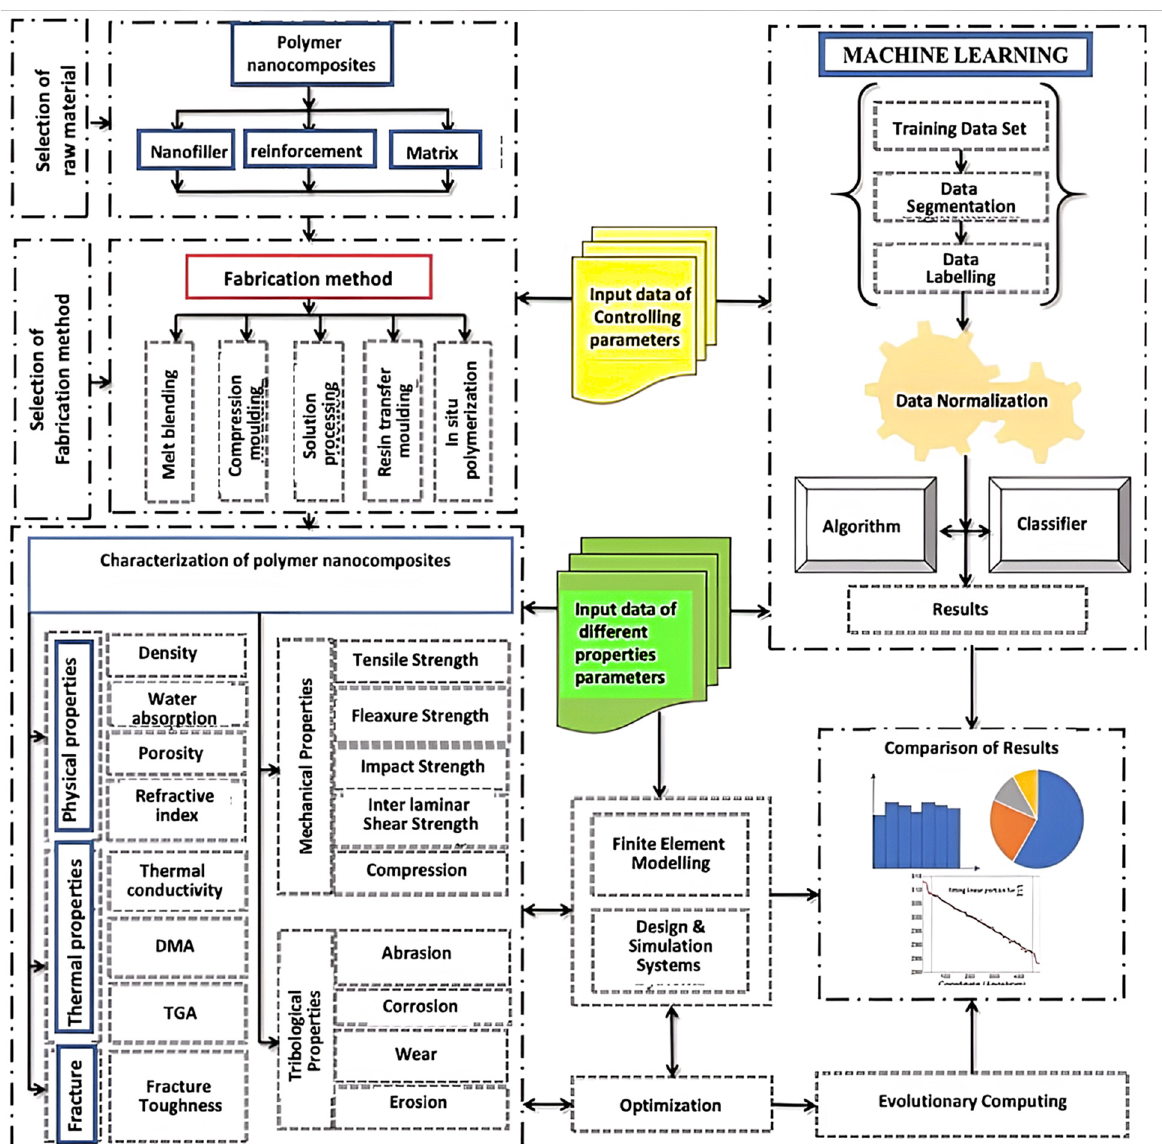
Figure 3. Application of machine learning for predicting the properties of polymeric nanocomposites.